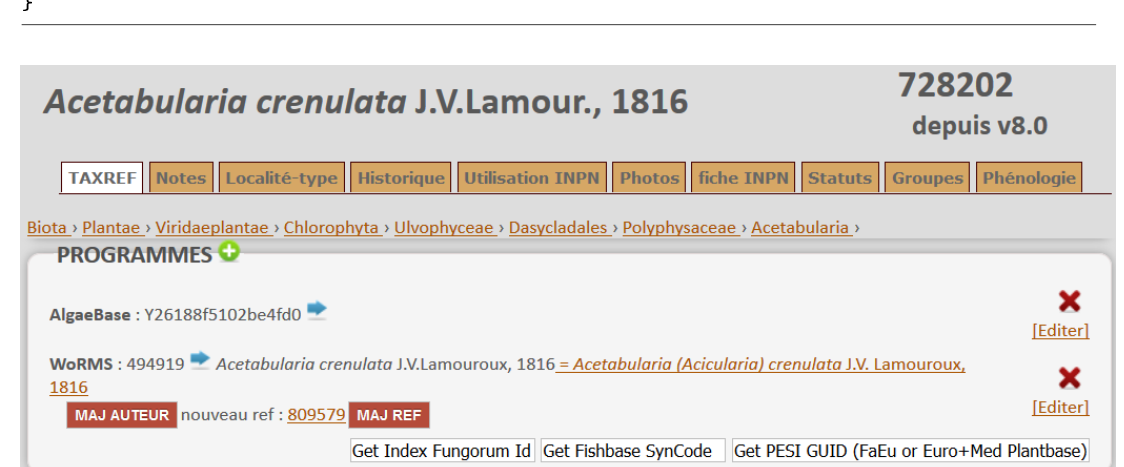
Figure 8. TAXREF-Web suggestions for editing taxon Acetabularia crenulata